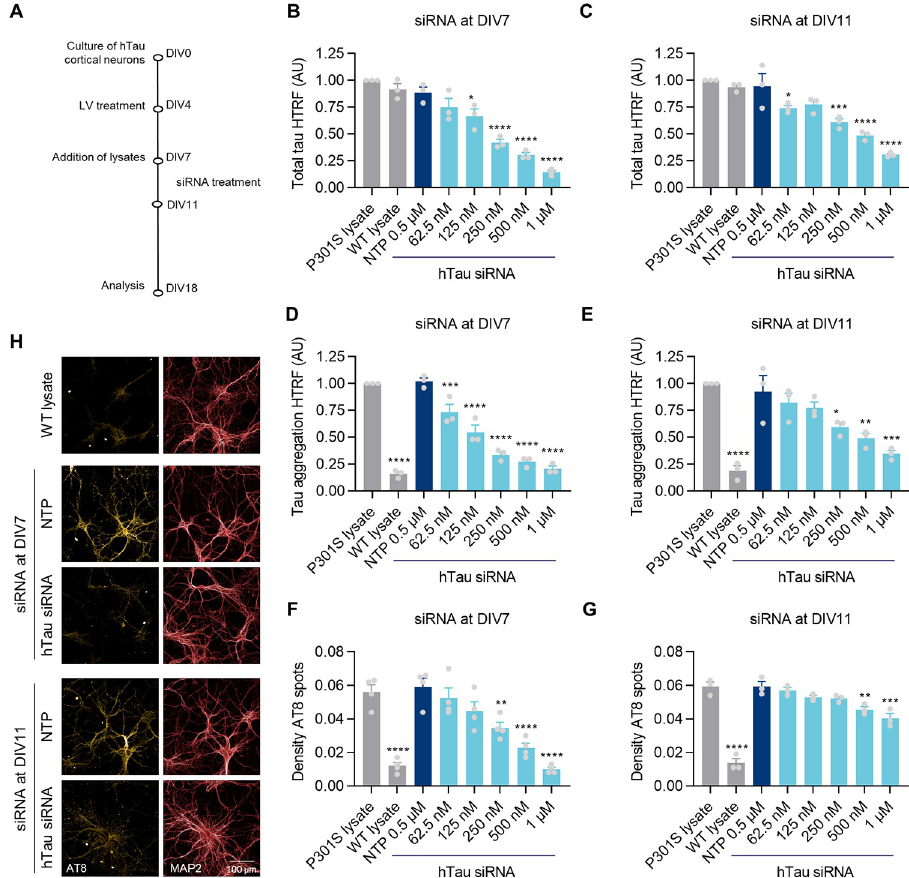
Fig 6. Human tau knock-down by siRNA decreases tau inclusions in seeded hTau primary neurons. A) Diagram of experimental design. hTau primary neurons transduced with T7-P301S LV at DIV4 were treated with WT or P301S lysates at DIV7 and increasing concentrations of human hTau siRNA, from either DIV7 or DIV11. Non-targeting pool (NTP) siRNA at 0.5 μ M was used as a control. Cells were lysed for HTRF assay or fixed for immunofluorescence at DIV18. Total tau HTRF of seeded primary neurons treated with siRNA at DIV7 ( B ) or DIV11 ( C ). Accumulated tau as measured by Tau aggregation HTRF ( D-E ) or Triton-insoluble AT8 spots as quantified by IF ( F-G ). Grey bars: treatment with T7-P301S and WT or P301S lysates, without siRNA. Blue bars: treatment with T7-P301S LV, P301S lysate and siRNA as indicated in the graph. Data shown as mean ± SEM, n = 3 independent experiments. One-Way ANOVA with Dunnett’s multiple comparisons test, all conditions compared with NTP treatment. H ) Representative images from hTau neurons treated as in (F-G) with 0.5 μ M of NTP or hTau siRNA.